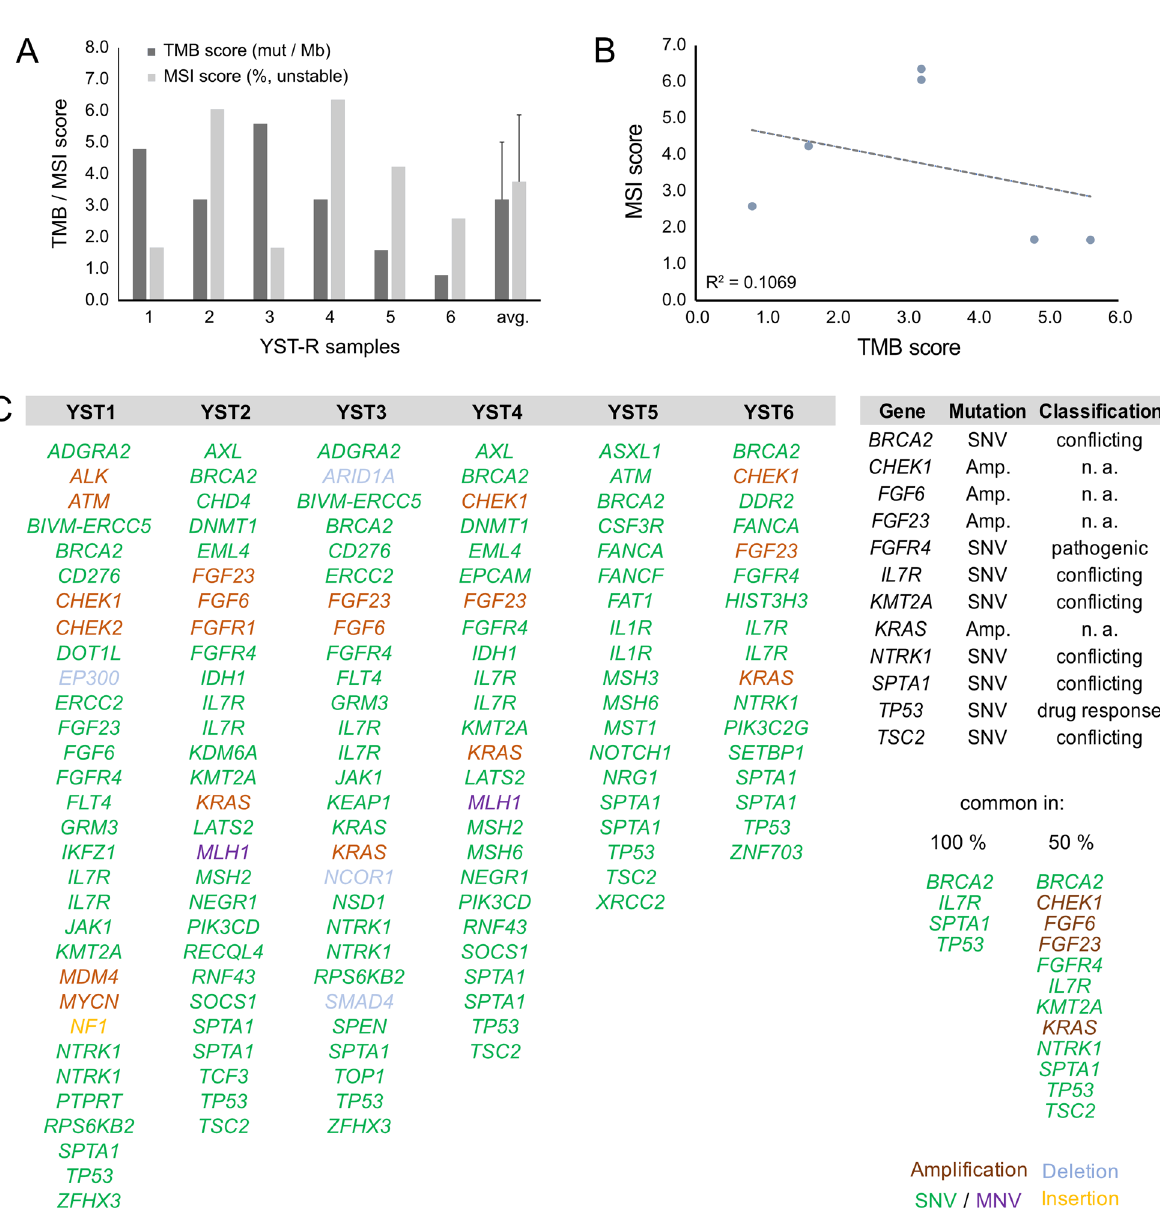
Fig. 2 Mutational profiling of YST‑R. A Tumor mutational burden score (TMB) and microsatellite instability score (MSI) found in six cisplatin‑resistant YST samples. B Pearson’s correlation plot of TMB and MSI. C List of identified individual and common genomic alterations found in six cisplatin‑resistant YST